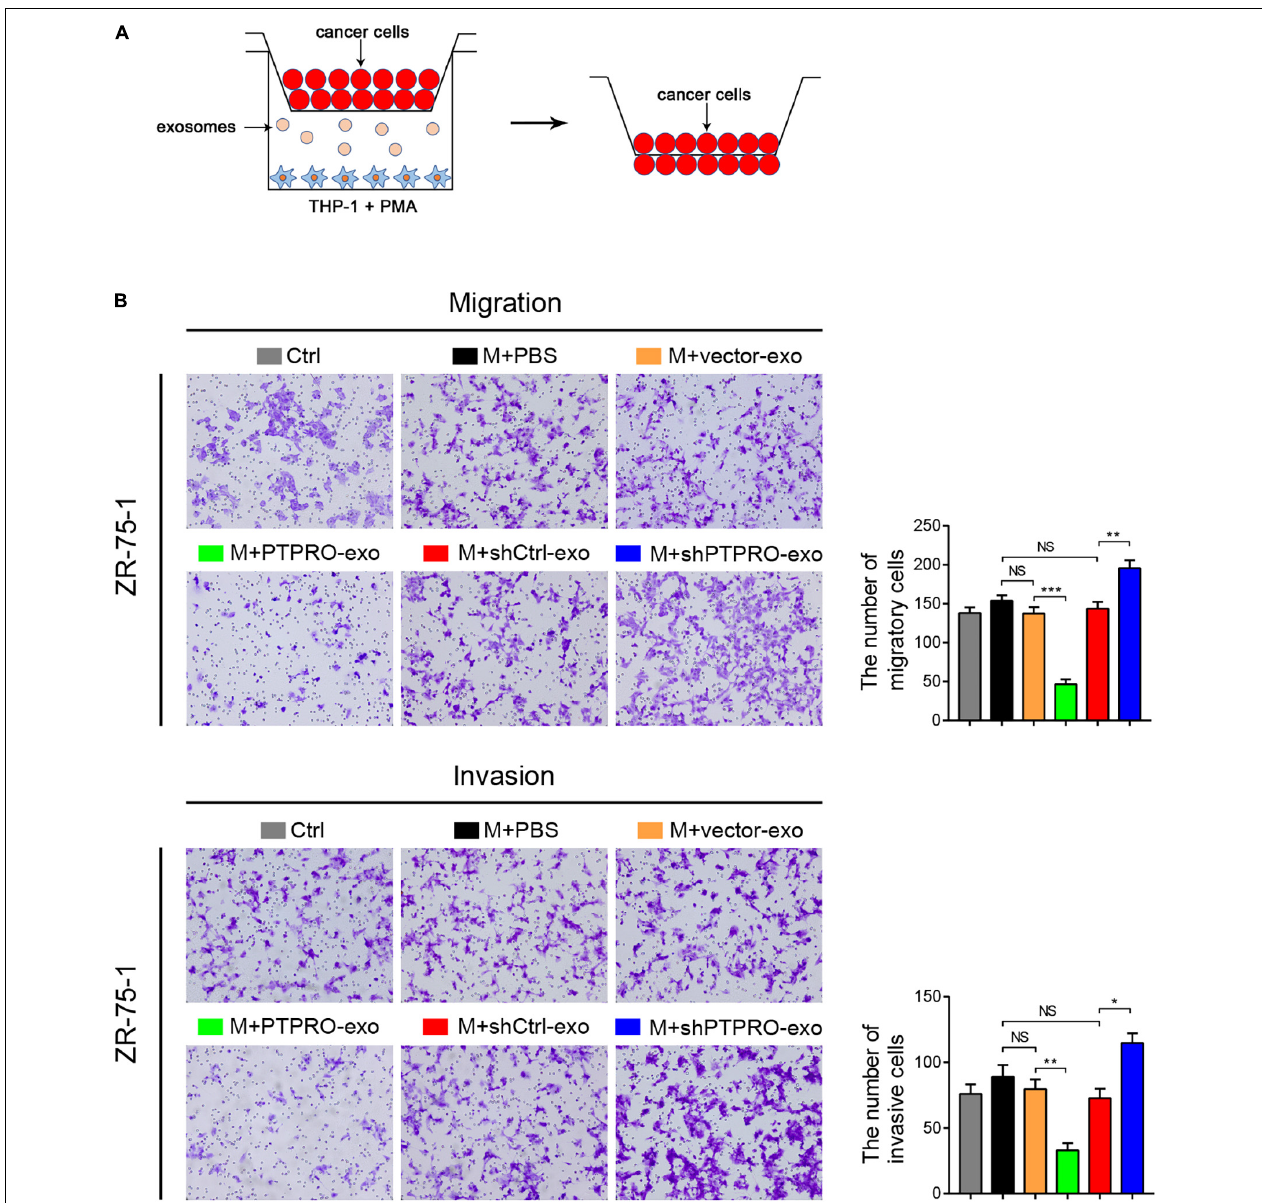
FIGURE 4 | Tumor cell-derived exosomal PTPRO inhibited cancer cell invasion and migration. (A) Schematic illustration of the in vitro transwell co-culture system. (B) Cell migration and invasion assays were used to study the migration and invasion ability of ZR-75-1 cells. THP-1 cells prestimulated with PMA were treated with ZR-75-1-vector-exo or ZR-75-1-PTPRO-exo and ZR-75-1-shCtrl-exo or ZR-75-1-shPTPRO-exo at a concentration of 25 µ g/mL or PBS; then, the upper chamber was obtained and incubated with ZR-75-1 cells for 24 h. Original magnification: 200 × . Error bars, SEM. * P < 0.05; ** P < 0.01; *** P < 0.001 by a one-way ANOVA with post hoc intergroup